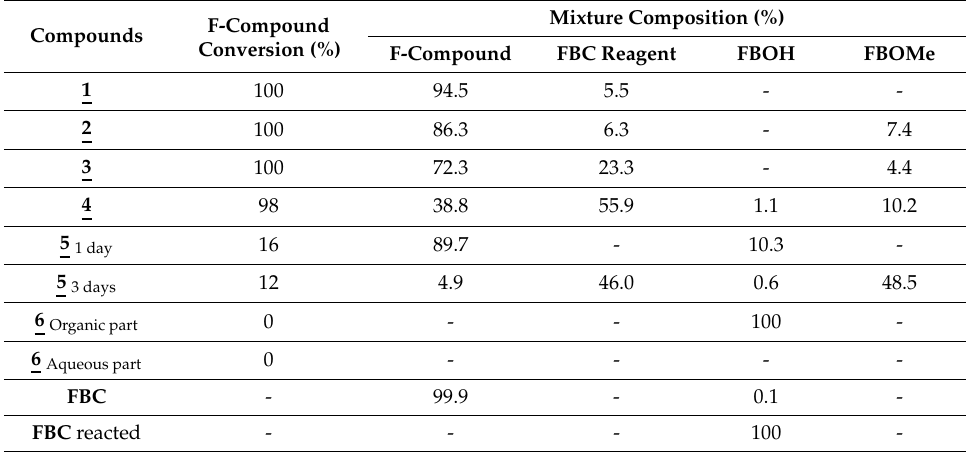
Table 4. Conversion and mixture ratio of model compound fluorobenzylation, calculated from 19 F-NMR data.